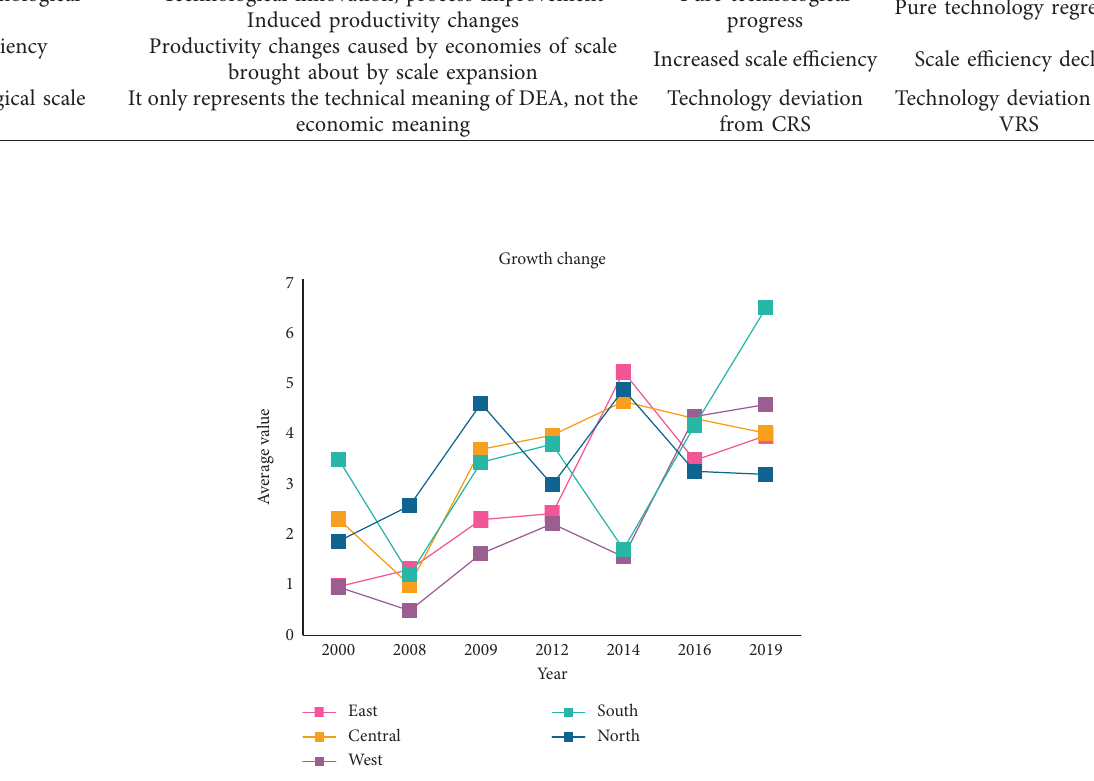
Figure 16: Average TFP of east, mid, and